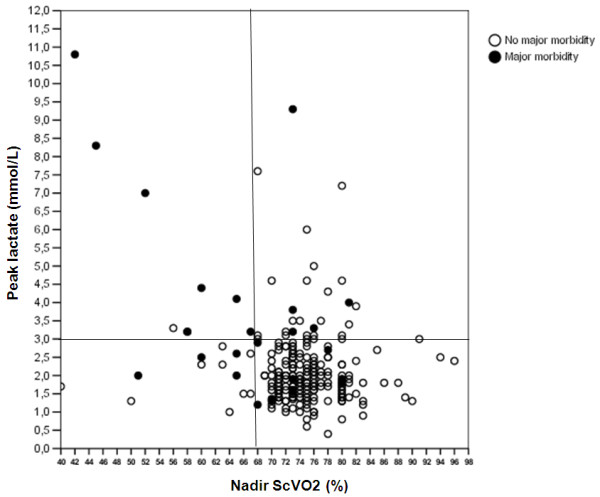
Patient distribution according to the cut-off values of 68% (nadir ScVO2) and 3 mmol/L (peak lactate).